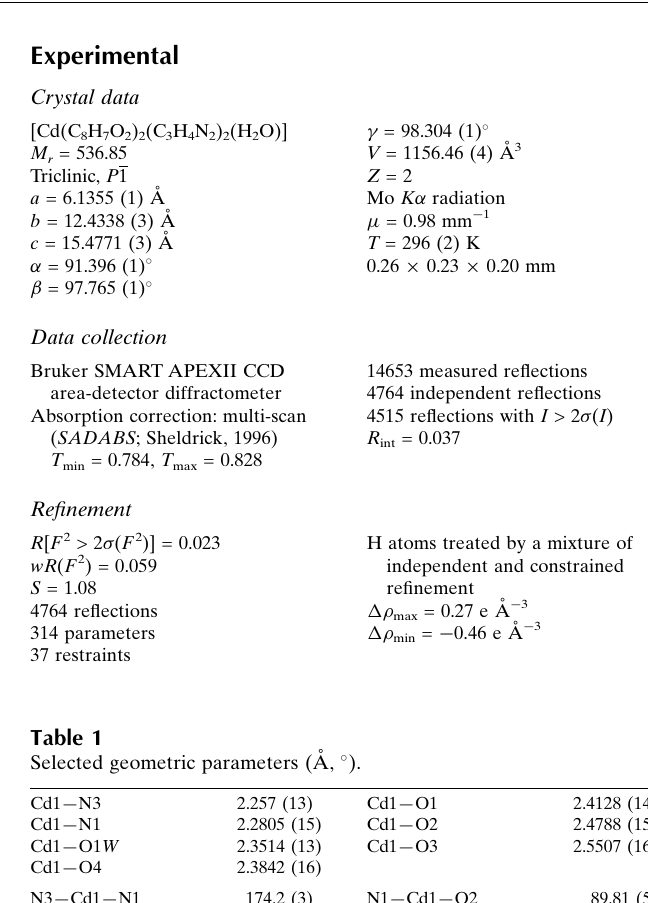
Selected geometric parameters (A˚ , (cid:2) ).